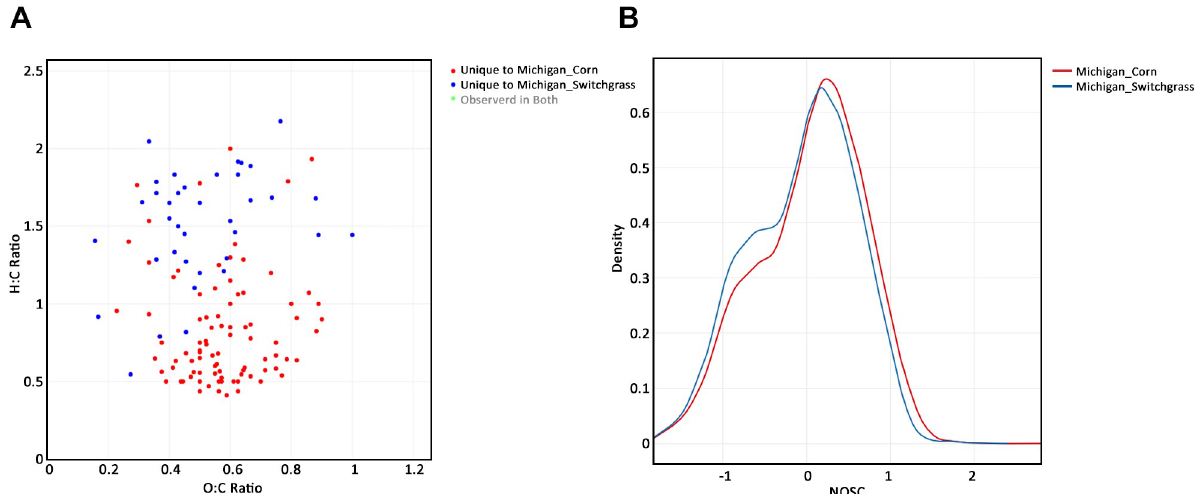
Fig 4. (A) Van Krevelen plot of peaks uniquely observed in Michigan corn and Michigan switchgrass samples. (B) NOSC density curves for Michigan corn and switchgrass groups.